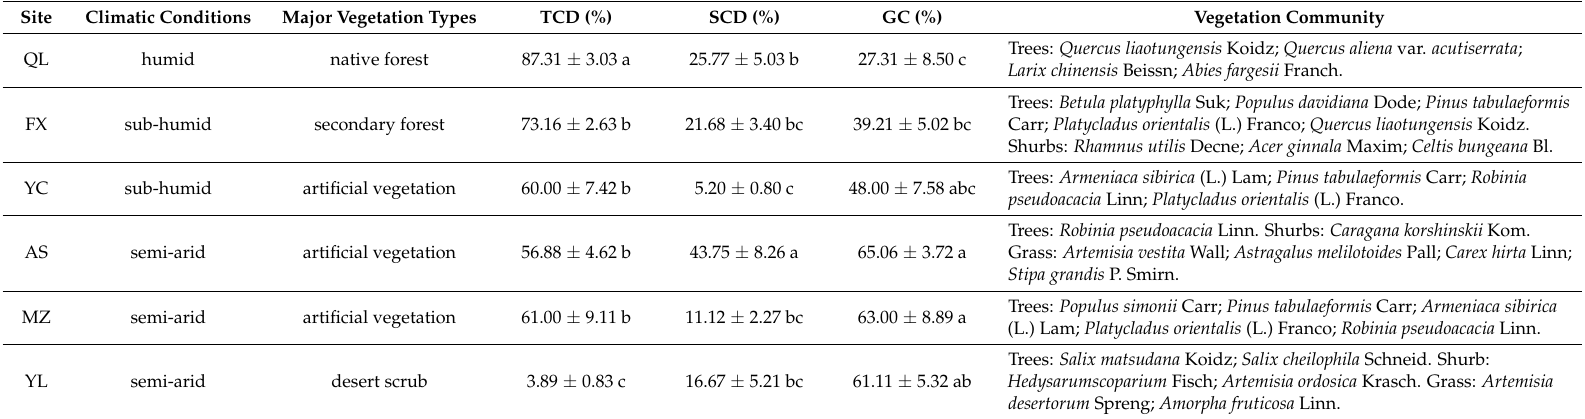
Table 2. Detailed vegetation characteristics of each research